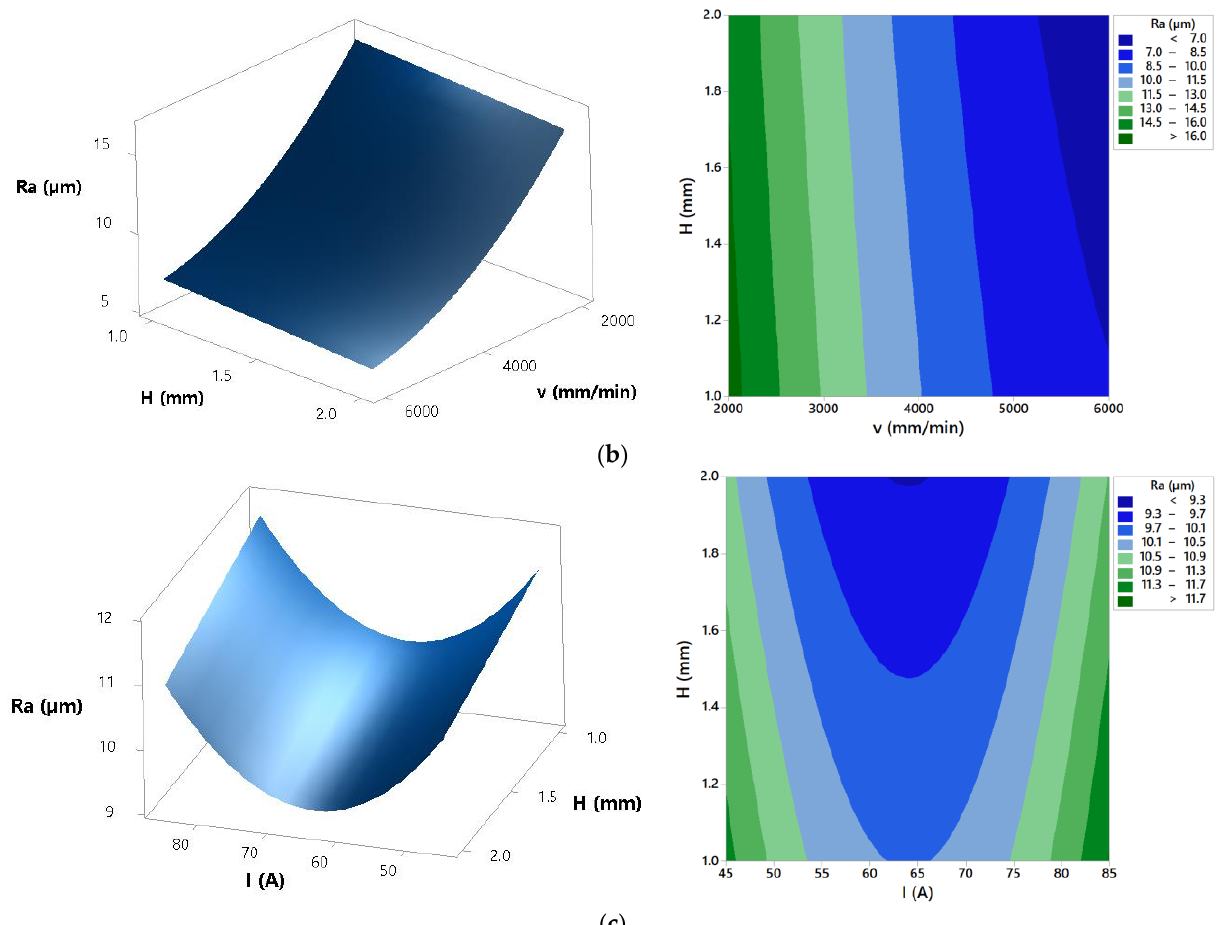
Figure 10. Effects of process parameters on surface roughness Ra : ( a ) H = 1.5 mm, ( b ) I = 65 A, and ( c ) v = 4000 mm/min